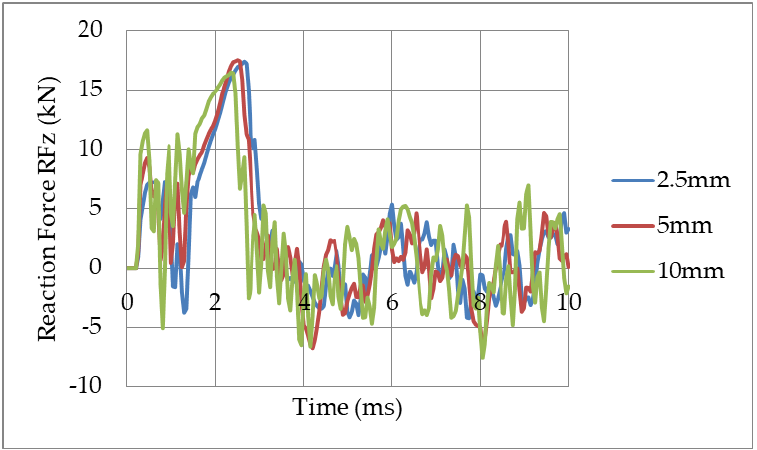
Figure 8. Variation of Reaction Force (RFz) in a single support with respect to mesh size 2.5 mm, 5 mm and 10 mm, for the trapezoidal sandwich panel subjected to 0.5 kg of TNT at R = 0.5 m (BI-5). Table 4. The average difference in percentage (%) of a specific mesh size in relation to mesh size 2.5 mm. Considered output